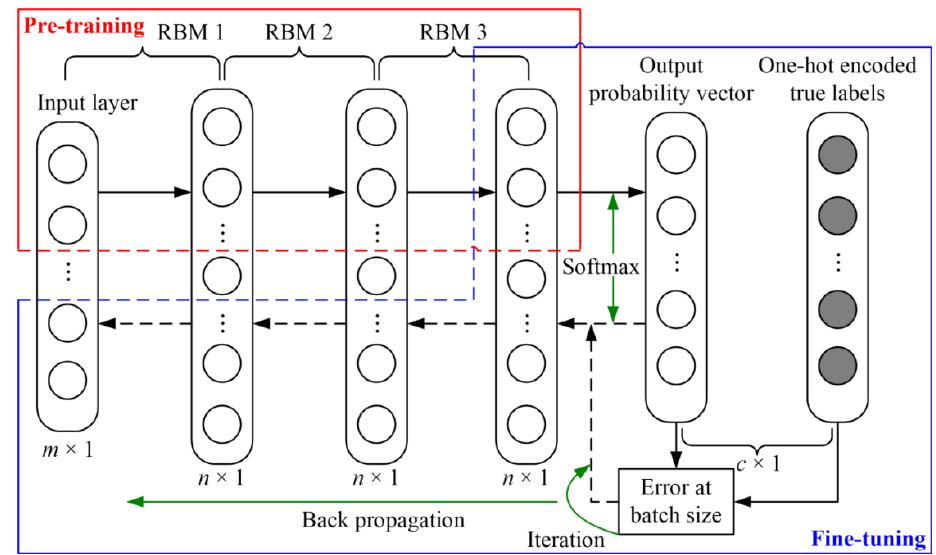
Figure 3. The structure of deep belief network. RBM: restricted Boltzmann